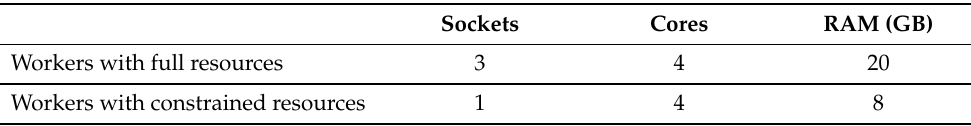
Table 4. Virtual resources used per emulated deployment scenario.